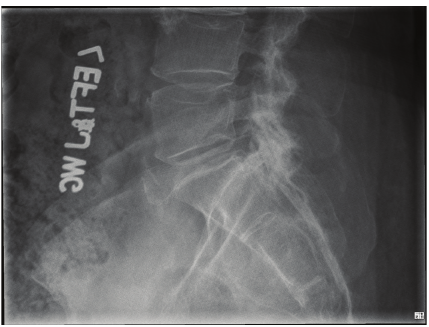
Figure 1: Lateral lumbar X-ray normal lumbosacral alignment and anatomy.